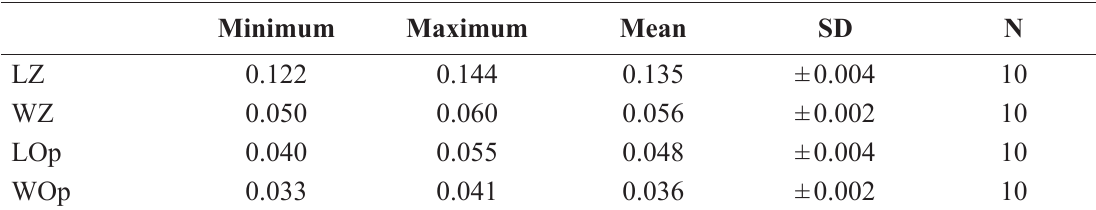
Table 9 . Measurements in mm of ? Tretosina gen. et sp. indet. (GIS/B 0522 to 0532), Aquitanian, lower Miocene, Kharinadi Formation, western Kachchh, Gujarat, India. Abbreviations: see Material and methods.